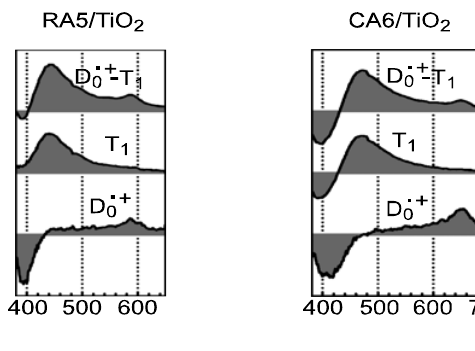
Figure 6. SADS (upper panels) and time-dependent changes in population (lower panels), obtained by singular-value decomposition (SVD) followed by global fitting, for RA5–CA8 bound to TiO nanoparticles in suspension (reprinted from [4] with permission of the 2 American Chemical